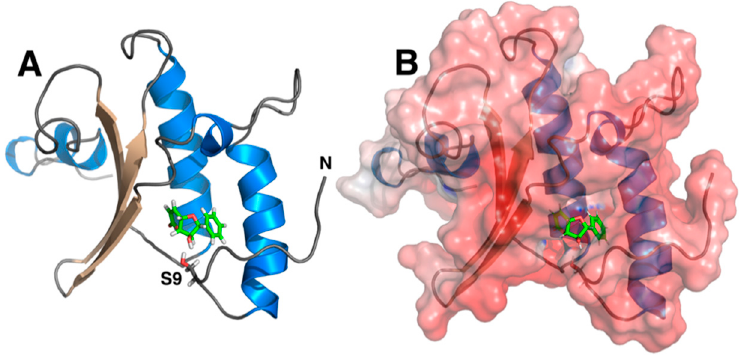
Figure 5. ( A ) Cartoon representation of the structure closest to the average structure of an ensemble of solution-state NMR structures calculated for Rv1466 (5IRD). Docking experiments show that the altholactoneboundintoapocketformedbyathree-strand β -sheet(pale)andtwoparallel α -helices(blue). The atoms of the stick representation of altholactone are colored green (carbon), red (oxygen), and white (hydrogen). The side chain of a serine residue, S9, near the altholactone is highlighted. ( B ) Surface renditions of the single structure shown in Figure 5A with a stick representation of